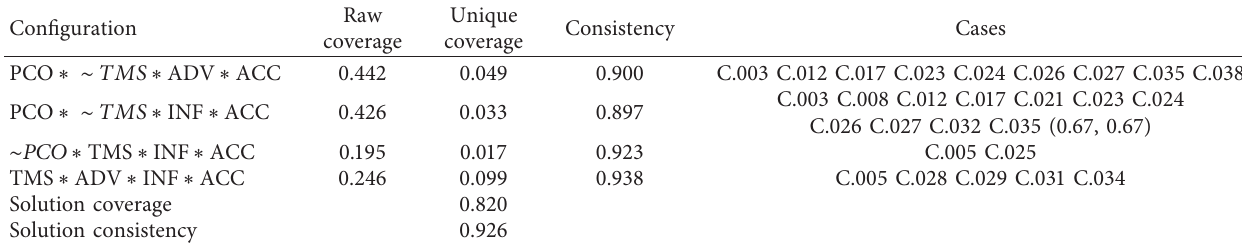
Table 3: Truth table minimization results for positive impact of BIM usage satisfaction.